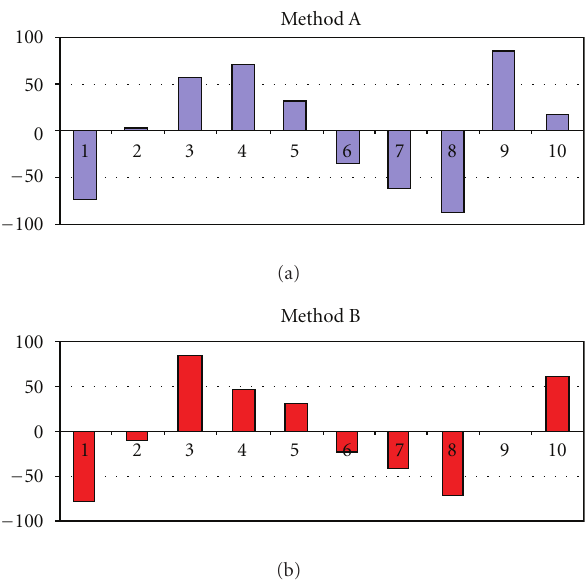
Figure 7: Residues test for calibration plots A and B, second-degree polynomials (equation according to Table